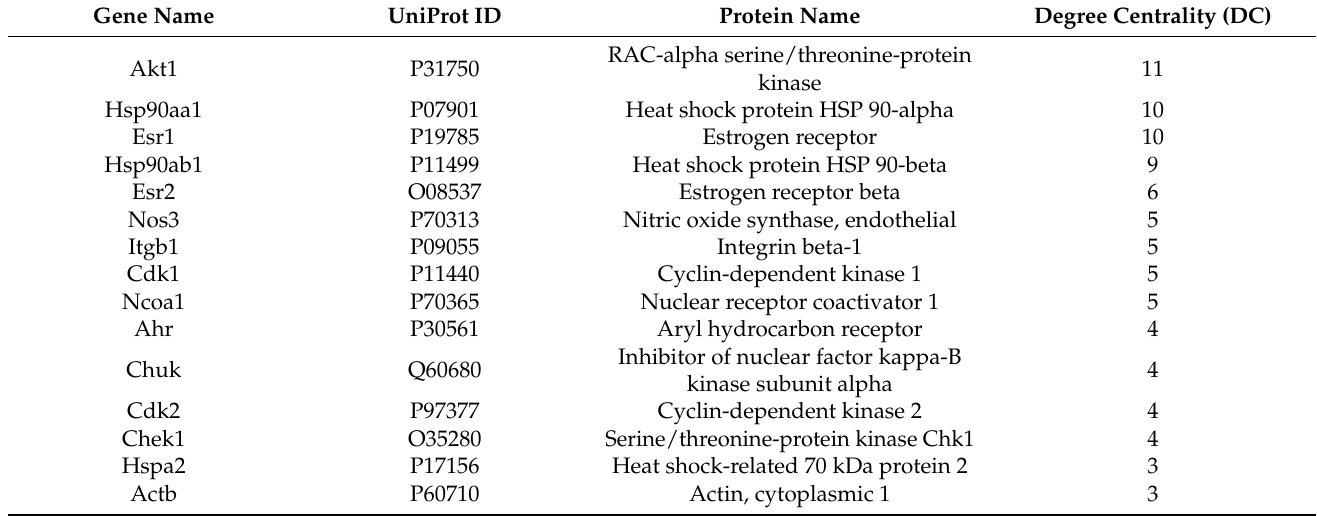
Table 1. Information of the core